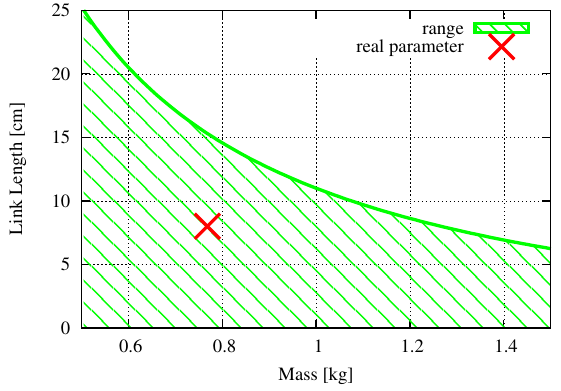
Figure 7. Designable range satisfying Equation (3). “ × ” highlighted in red represents the actual design parameter, and it satisfies Equation (3). Thus, MX-106T is able to generate enough driving torque as a base actuator.